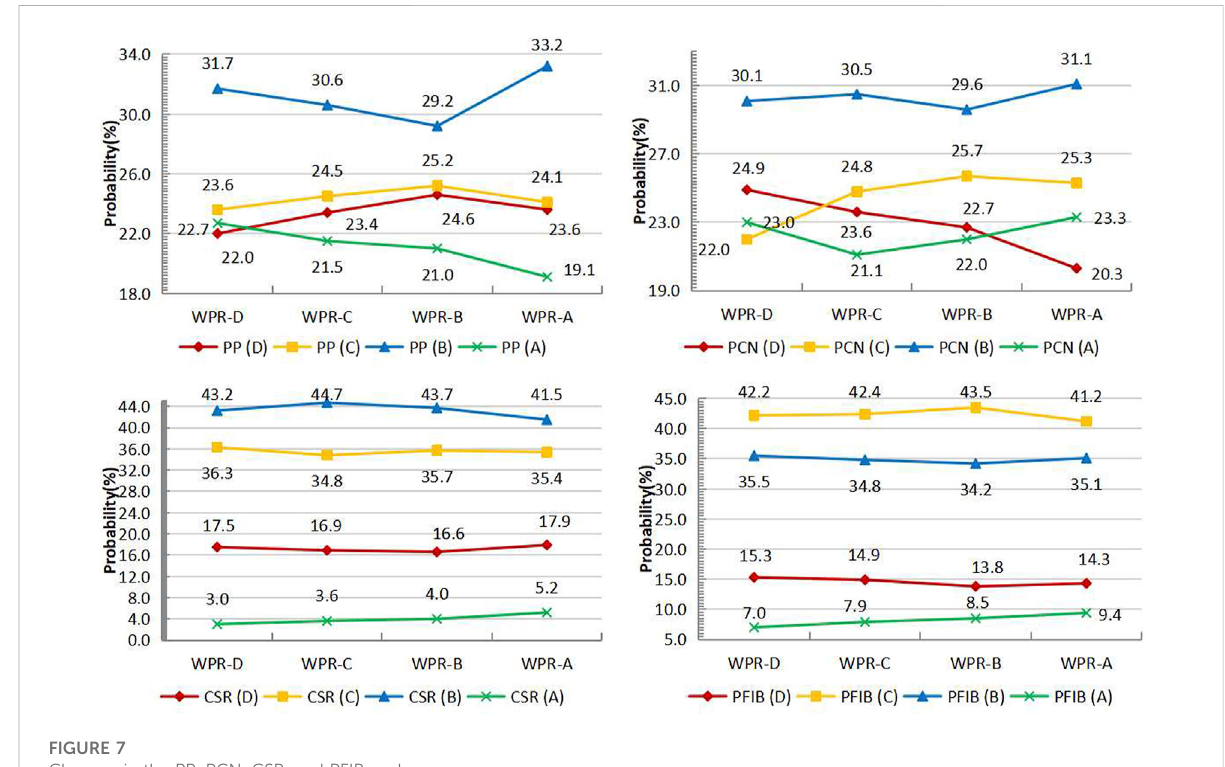
FIGURE 7 Changes in the PP, PCN, CSR, and PFIB